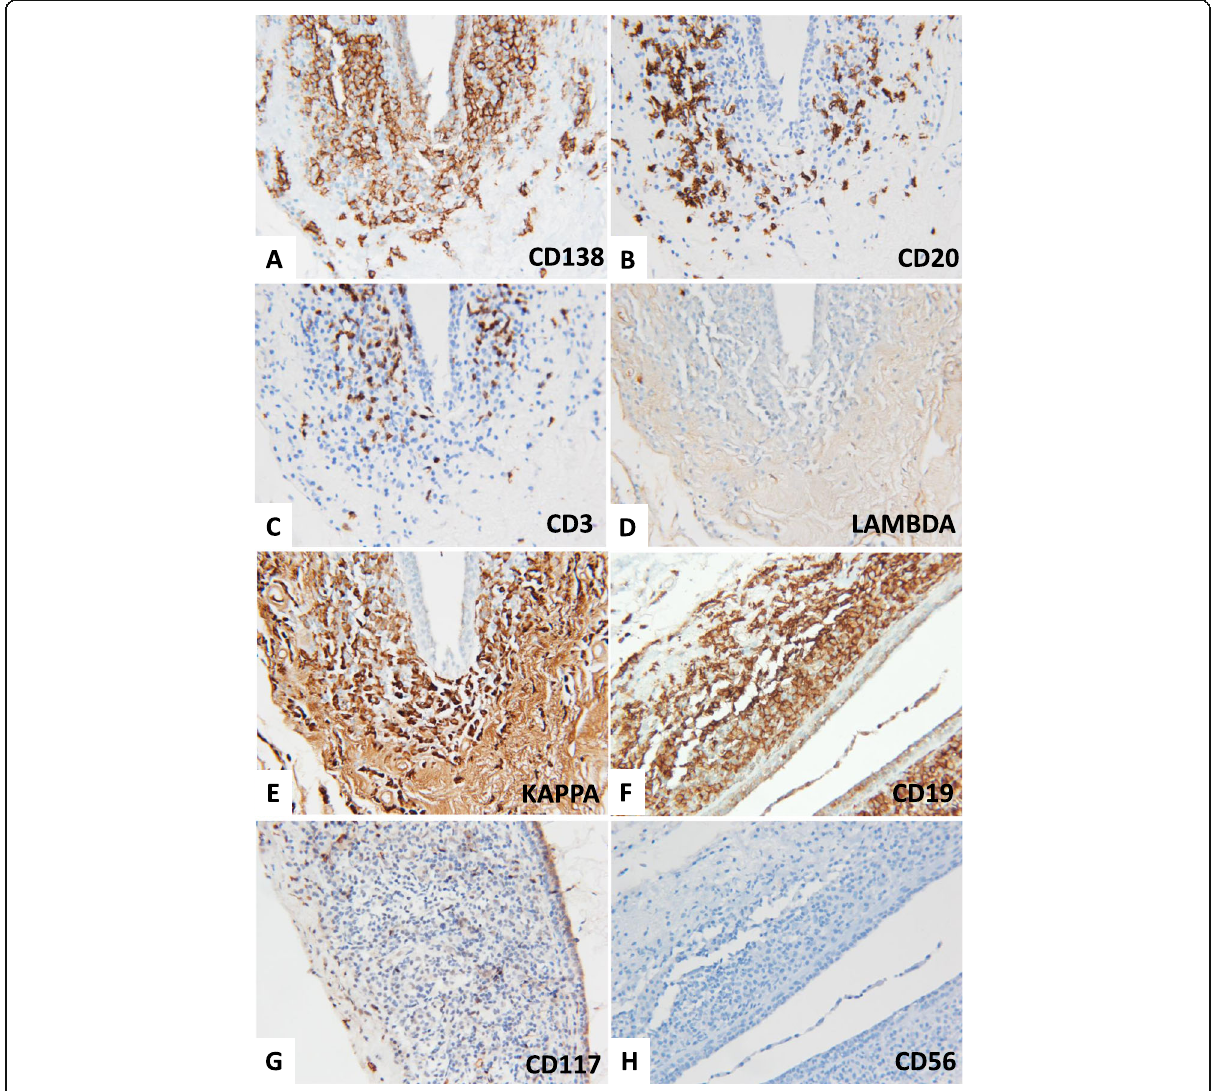
Fig. 2 Immunostains to characterize periductal inflammatory cells in lupus mastitis. a CD138 highlighting plasma cells in over half of the inflammatory cells. b CD20 and c CD3 immunostains highlight smaller populations of both B lymphocytes and T lymphocytes. d Lambda and e Kappa light chain immunostain showed the Kappa-restriction of plasma cells. Immunostains for f CD19, g CD117 and h CD56 indicated the non- neoplastic nature of the plasma cells. (Immunohistochemistry, original magnification, × 200 [ a-h